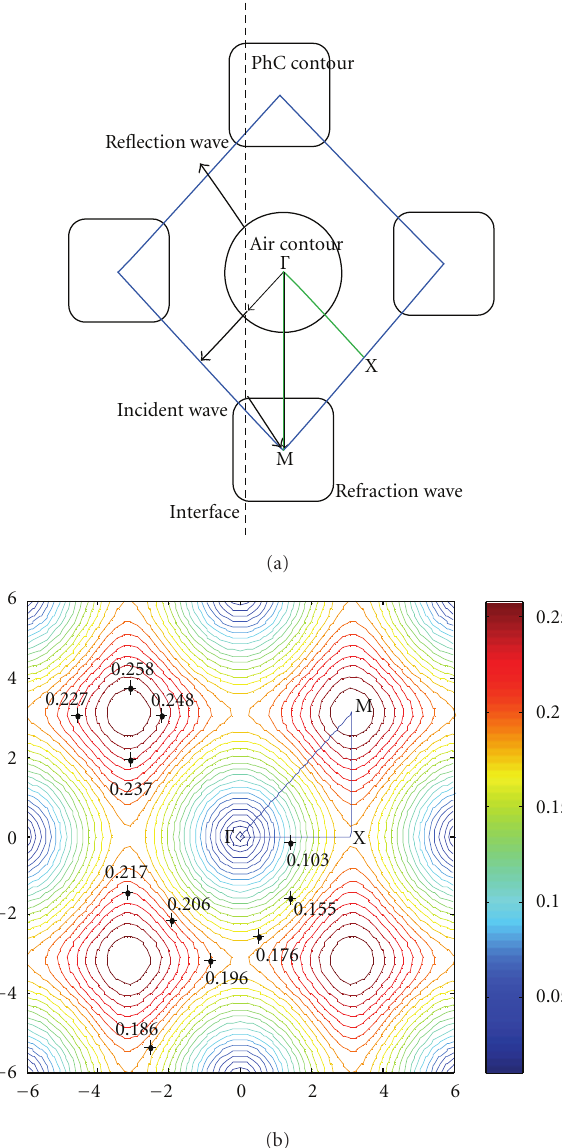
Figure 2: (a) Wave vector diagram of negative refraction in the PhC. (b) EFCs of the first band of the model PhC in AANR. Value of frequency is in unit of 2 πc /a